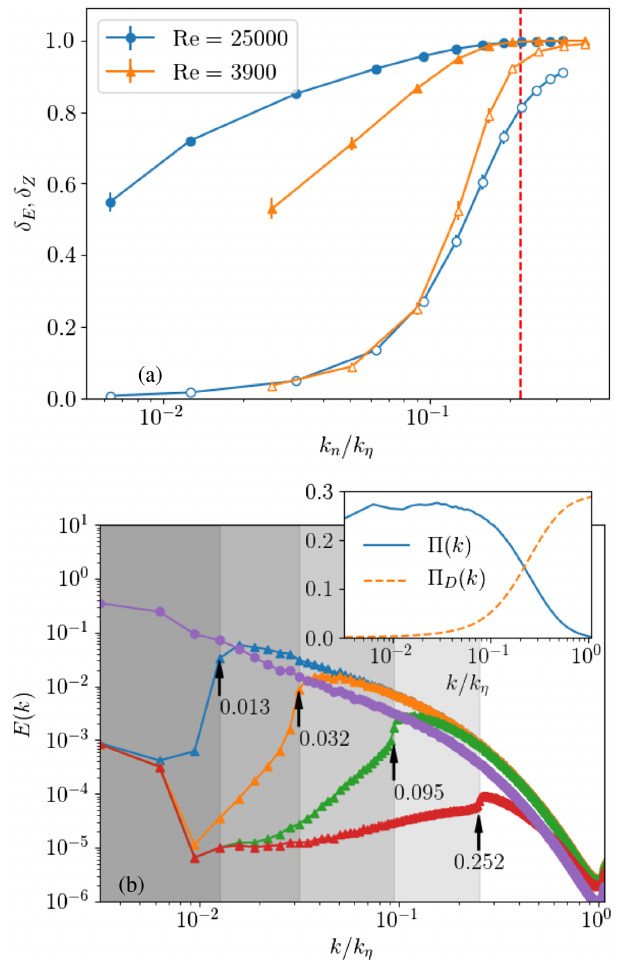
FIG. 10. (a) Values of the velocity correlations δ E (filled symbols) and the vorticity correlations δ Z (empty symbols) as a function of the maximum nudged wave number k n for different Reynolds numbers. Red dashed line marks the k c ∼ 0 . 2 k η value where transition to synchronization is obtained. (b) Energy spectra of the reference simulation RUN2 (round markers) and spectra of the difference field u Δ at different k n (triangular markers). The value of k n =k η for each nudged simulation is annotated with arrows. Inset: Nonlinear and viscous contributions to the energy fluxes for the reference simulation